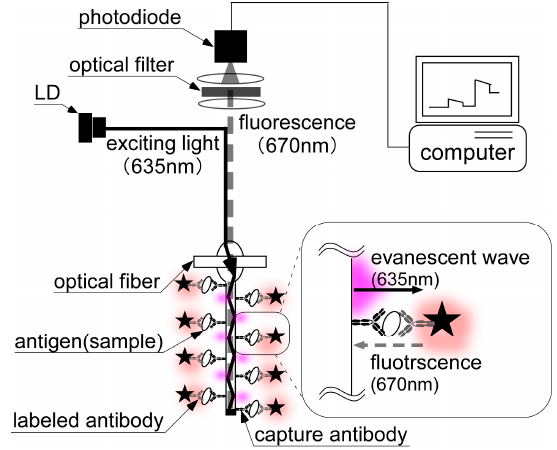
Figure 1. Assay principle of fluorescent immunoassay using optical fiber.